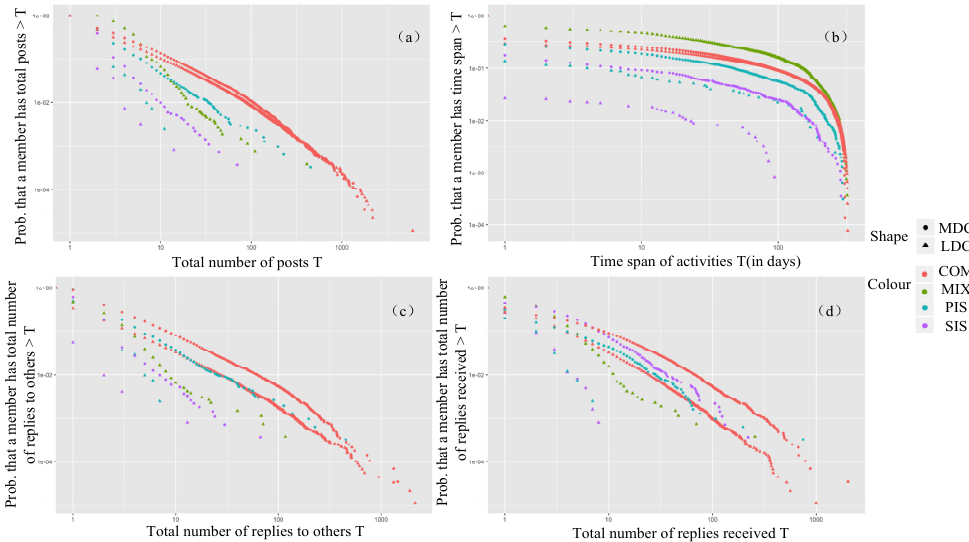
Figure 6. Complementary cumulative distributions of engagement metrics for the different clusters of informational support: ( a ) productivity, ( b ) loyalty, ( c ) social activity, and ( d ) attention received.